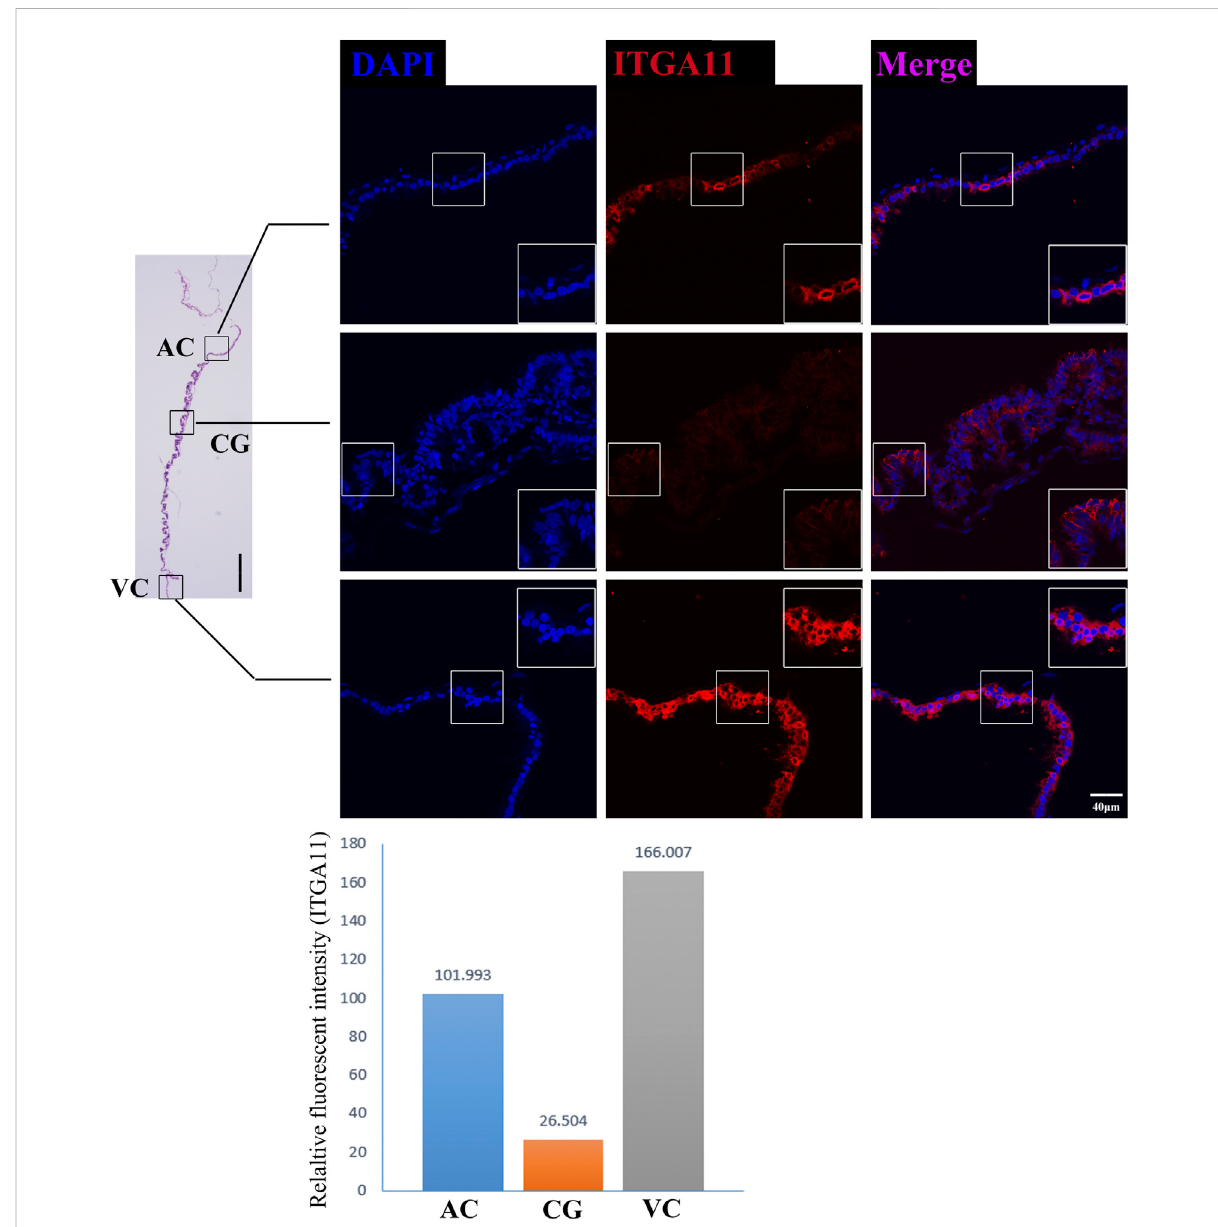
ITGA11 immuno fl uorescence on day 30 equine chorion. Histological images including allantochorion (AC), chorionic girdle (CG), and vitelline- chorion (VC) are used to clarify the location of the immuno fl uorescence view. Below, the histogram shows the fl uorescence intensity for red fl uorescence of ITGA11. An enlarged view of the area is shown in the white frame. Left bar = 400 μ m, right bar = 40 μ